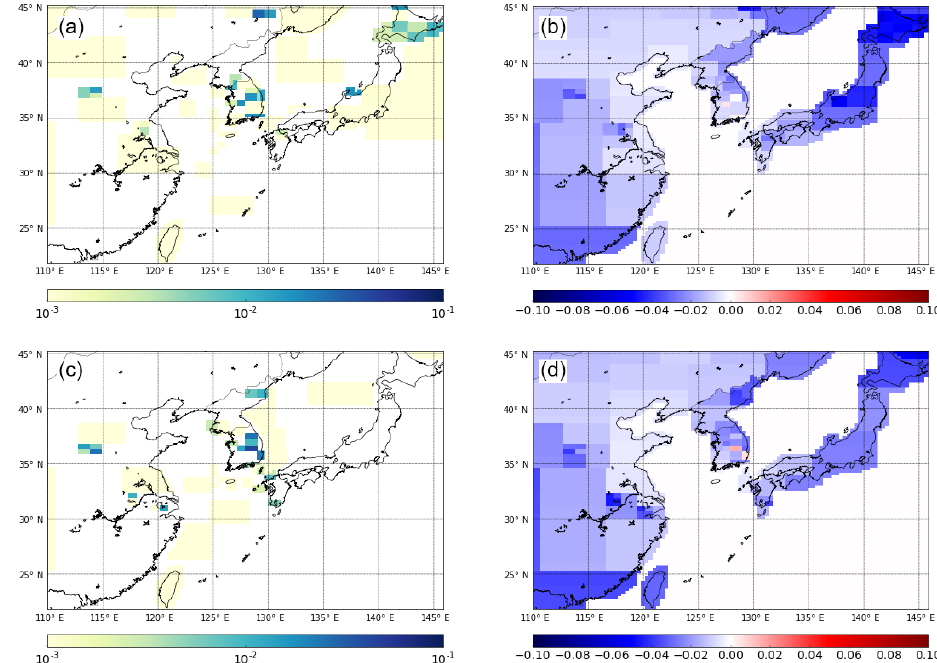
Figure 7. Emission maps for both years of data available for NF 3 : panels (a) and (c) show posterior emission maps for the years 2014 and 2015, respectively. Panels (b) and (d) show the emission magnitude minus the uncertainty calculated for each inversion grid box for the years 2014 and 2015, respectively. Results are from inversions with initial uncertainty on the prior emission field is set to 100 times the emissions at each fine grid square. Units are in gm − 2 yr − 1